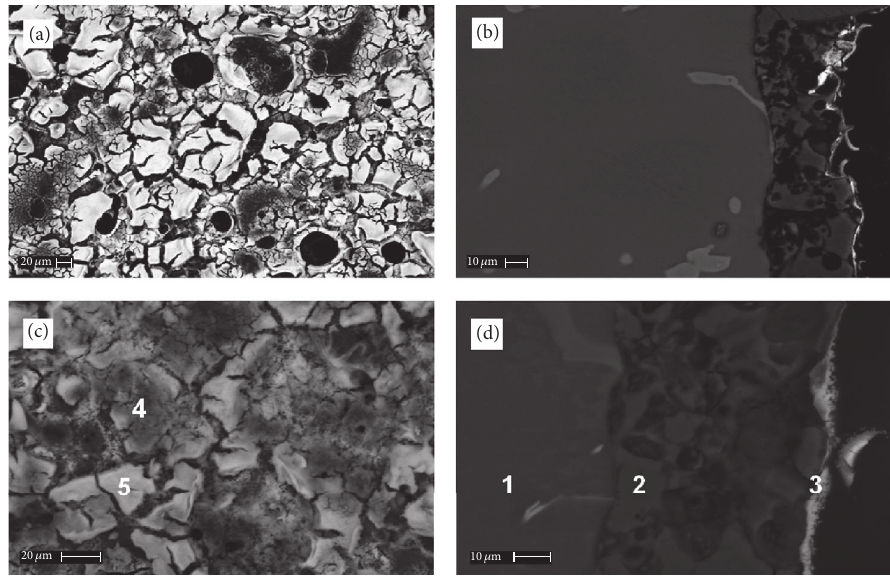
Figure 10: Scanning electron micrographs (backscattered electrons) of the surface and cross section of sealing coatings formed on AZ91 magnesium alloy with 12 g/l of La(NO 3 ) 3 at 50 ∘ C for 10 minutes (a-b) and 30 minutes (c-d).